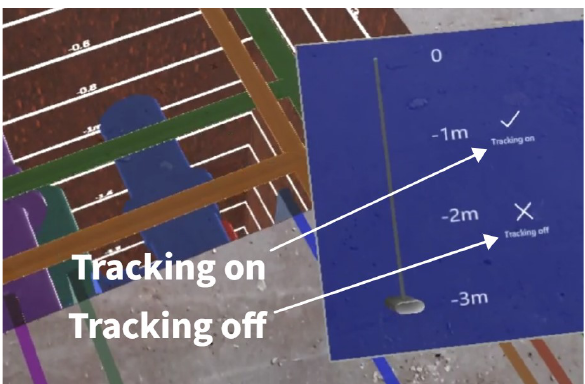
Figure 15. Tracking buttons to turn on-off in "X-Ray Box + Depthslider View"